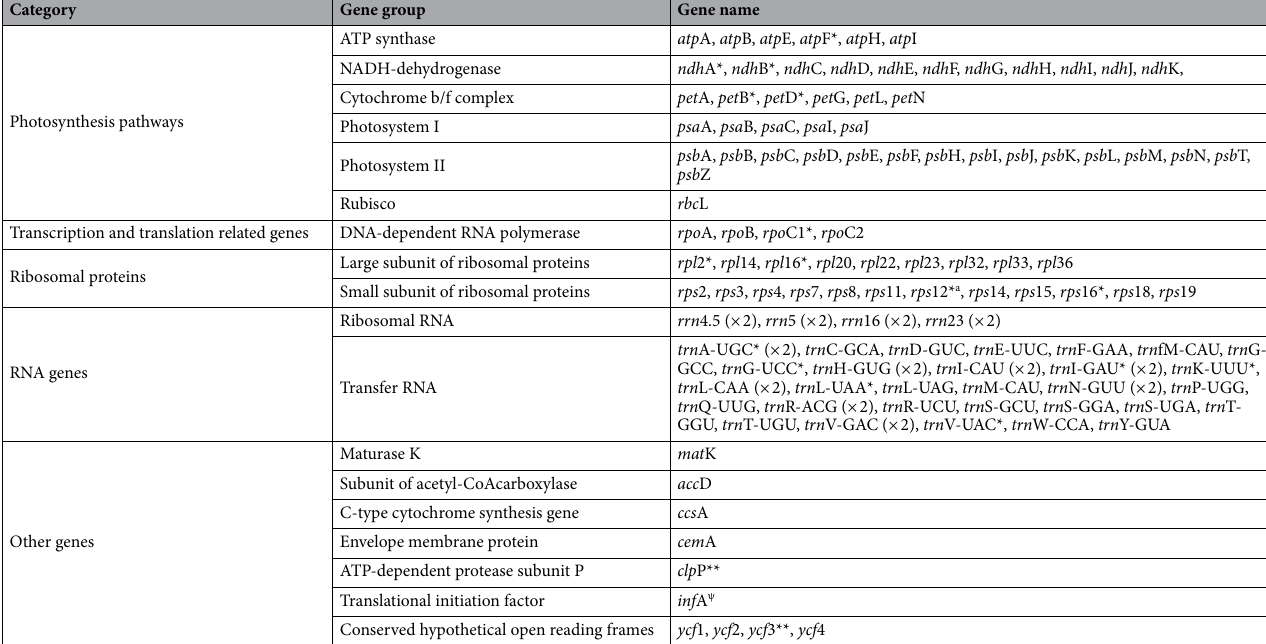
Table 1. Gene content and functional classification of L. ledebourii chloroplast genome. *Gene with one intron; ** gene with two introns; (×2) duplicated gene; a trans-spliced gene; ψ: